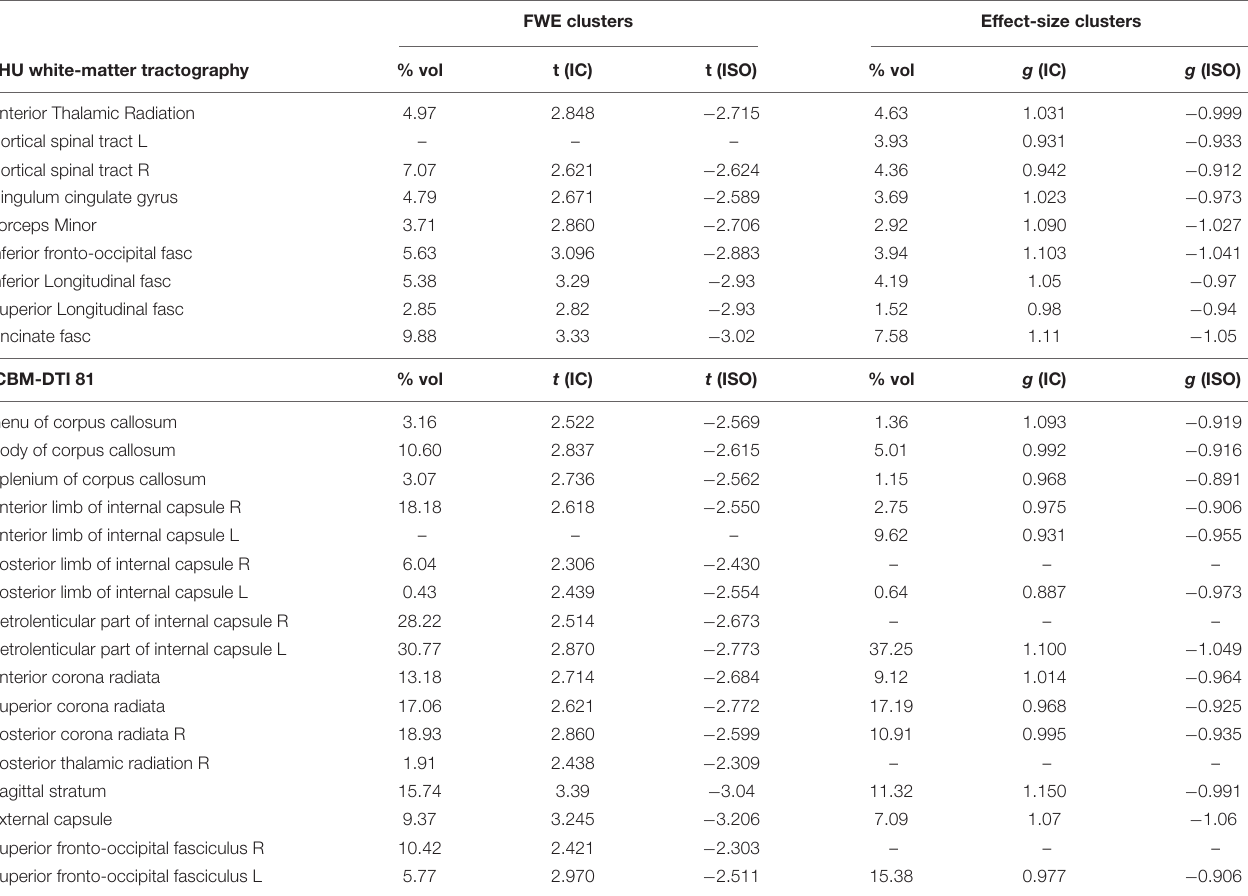
TABLE 3 | Significant overlapped clusters for both FWE < 0.05 and | g | > 0.82 for IC and